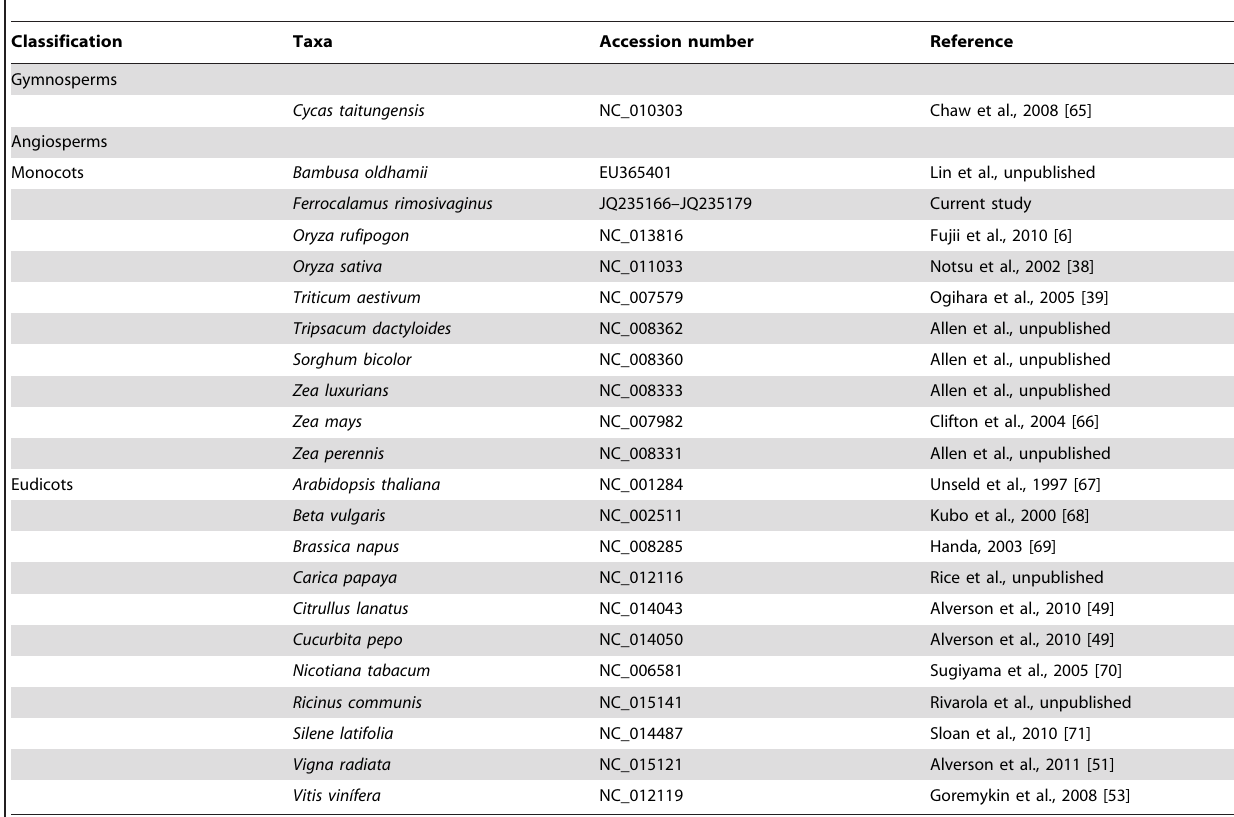
Table 1. Mitochondrial genomes of the 22 seed plants included in phylogenetic analyses in this